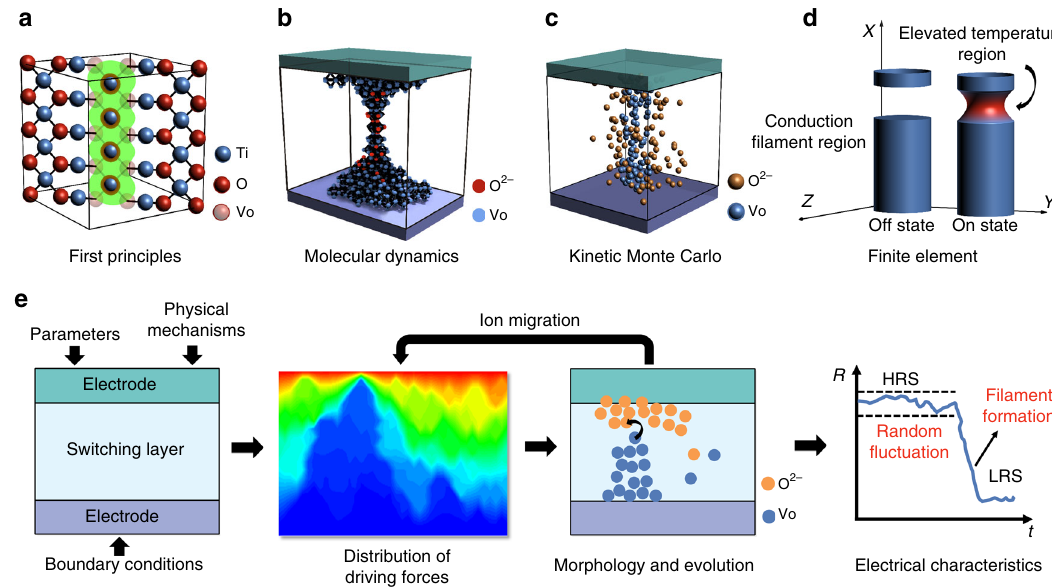
Fig. 5 Strategy for physical modeling of a memristor. a Schematic of the FP method to calculate the property of oxygen vacancies. b Schematic of the MD method to simulate the ionic migration dynamics. c Schematic of the KMC method to simulate the distribution of oxygen vacancies and interstitial ions. d Schematic of the FE method to calculate the morphology of conduction fi laments. e Flow chart of the suggested complete fl ow of physical modeling and numerical simulation on memristive devices. First the related physical equations and parameters are considered in the MIM structure. Then and distribution of driving force and ion motion in the switching layer are calculated. These calculations are repeated for many times as the whole switching process evolves multiple ion motion events. Finally, the electrical behaviors (e.g. variability and switching) of the memristor is output based on the microscopic simulation and electron transport